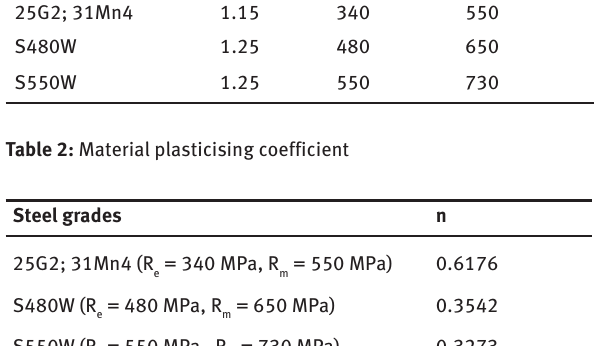
Table 1: Material factor γ